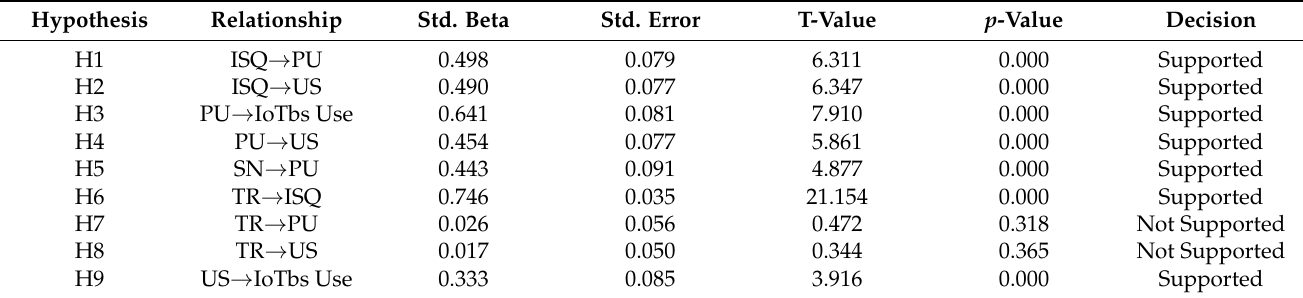
Table 6. Path coefficient